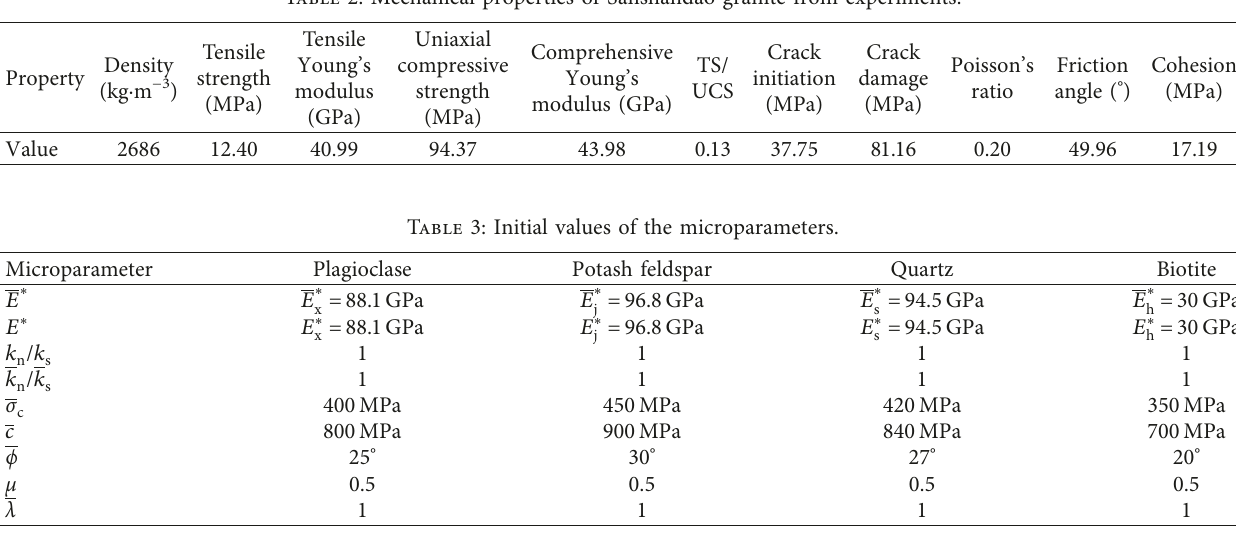
Figure 5: Mechanical test equipment: (a) uniaxial compression test and Brazilian disc test (WEP-600); (b) triaxial compression test (MTS- 810). Table 2: Mechanical properties of Sanshandao granite from experiments.